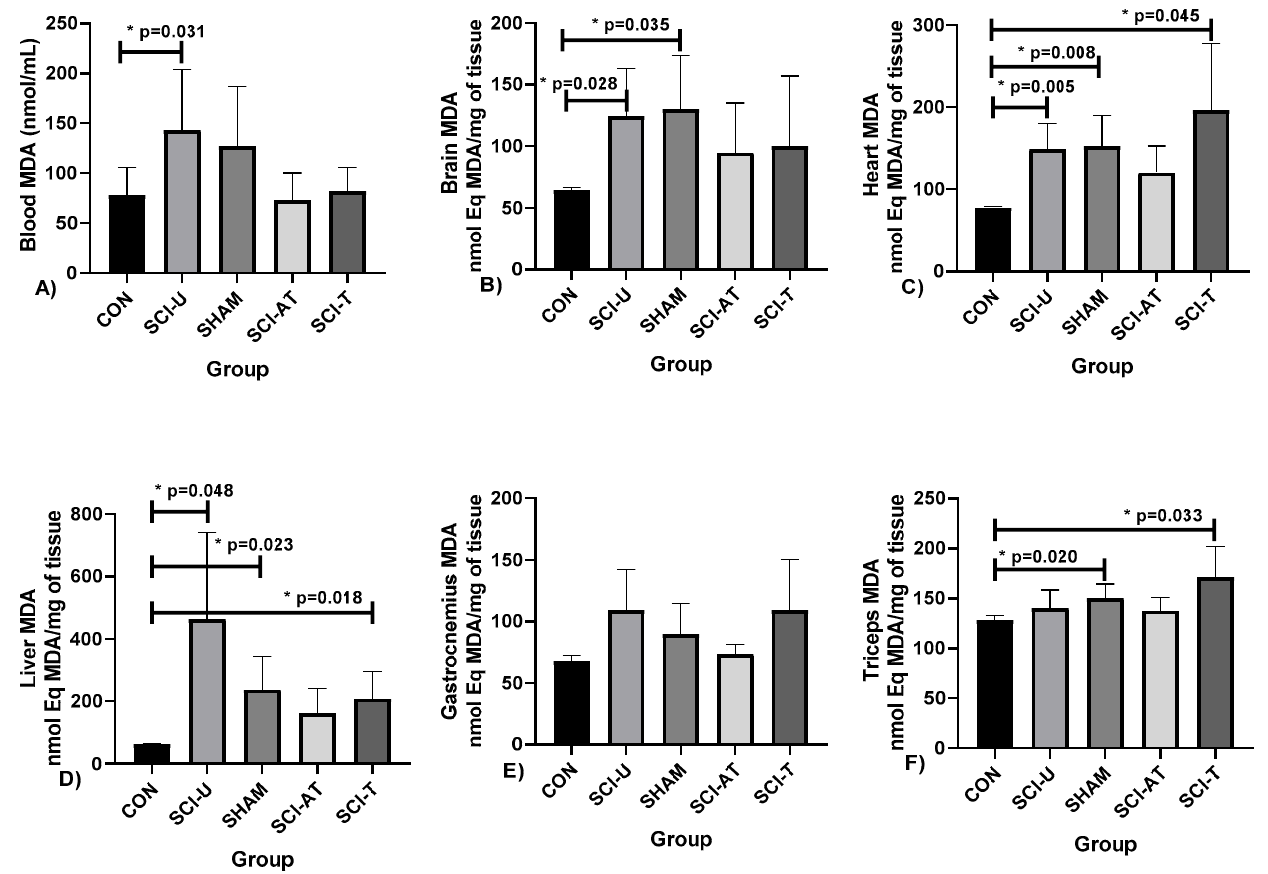
Figure 3. Malondialdehyde (MDA) levels measured in: ( A ) Blood, ( B ) Brain, ( C ) Heart, ( D ) Liver, ( E ) Gastrocnemius, ( F ) Triceps after interventions in the different groups: Control (CON), constituted by rats not exposed to any surgical procedure or treatment, Sham (SHAM), surgical control animals submitted to laminectomy surgery without SCI, SCI Untrained group (SCI-U), animals that underwent partial transection but were untrained, SCI Trained group (SCI- T), animals that underwent partial transection and were trained, SCI Active Trained group (SCI- AT), animals that trained previously, underwent partial transection and were trained again. * p < 0.05 ANOVA (one-way), and Bonferroni post hoc.